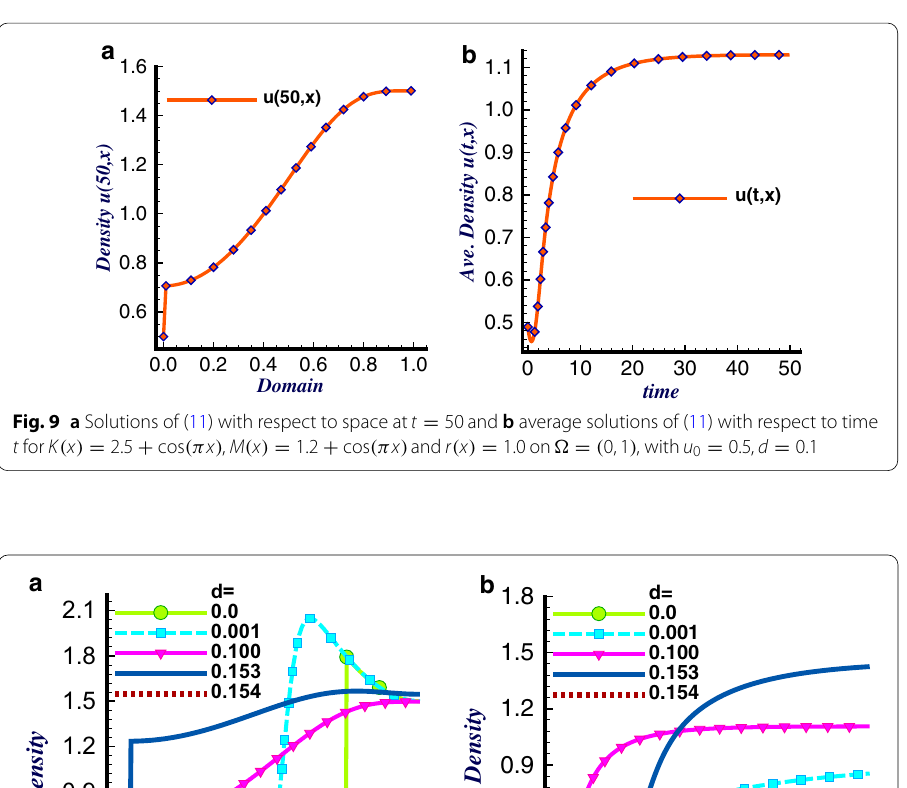
Fig. 10 Dynamical behavior of solutions of (11) for various diffusion coefficients at t solutions of (11) in ( b ) for K ( x ) initial density u